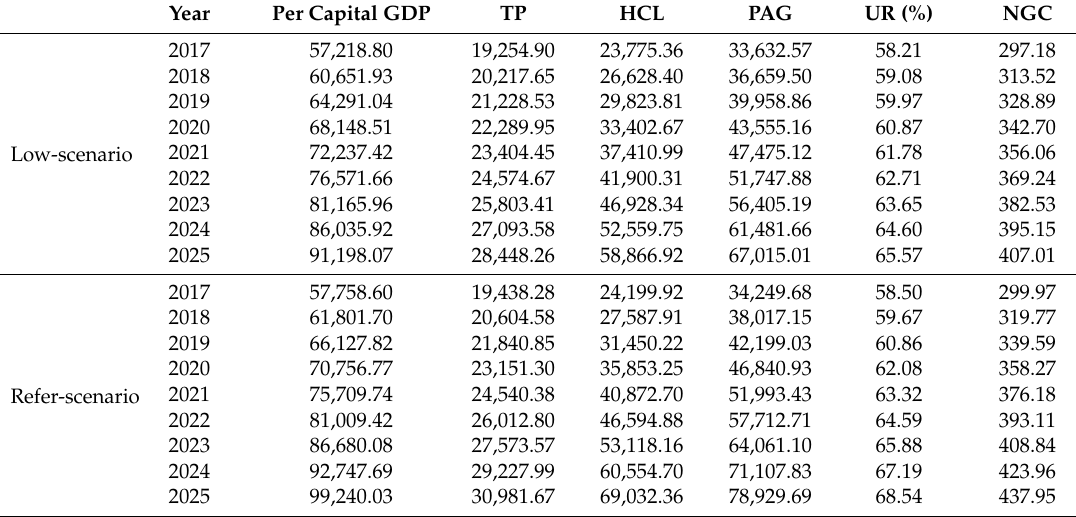
Table 6. Results for each scenario under different settings of affecting